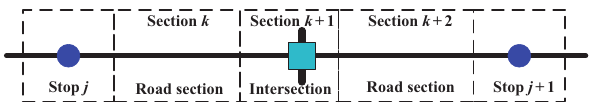
Figure 1 Three types of sections on one bus